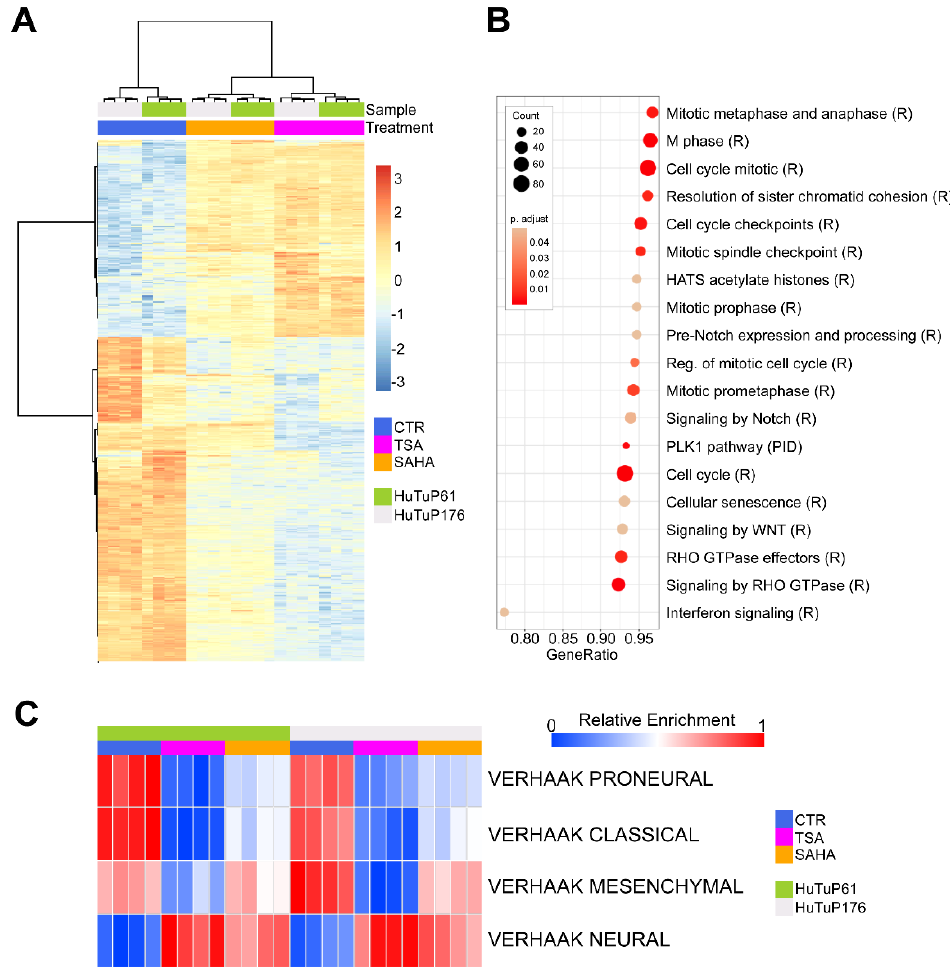
Figure 4. TSA and SAHA significantly modulate GBM cell transcription. ( A ) Heatmap displaying hierarchical clustering of control and HDI-treated GBM cells (5 μM for 24 h) according to the top variable transcripts. ( B ) Dot plot showing significant (FDR q value < 0.05) transcriptional enrichments (C2cp MSigDB) of common DEGs between TSA and SAHA treated cells as in ( A ). ( C ) Heatmap displaying relative enrichment of each sample subjected to GEP in the four different GBM molecular subtypes [2] from the C2cgp MSig database.